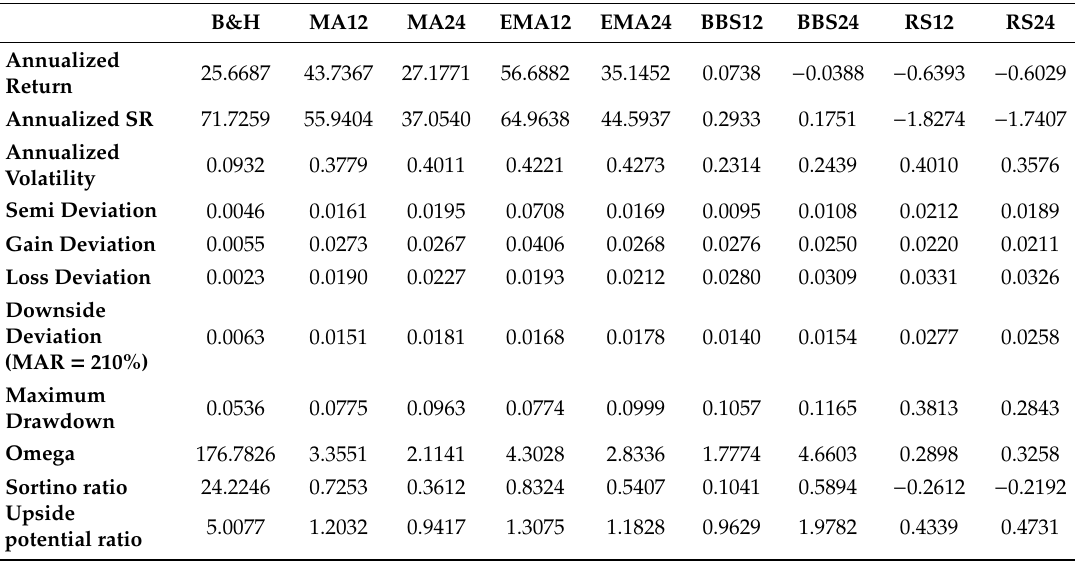
Table 5. Daily strategies